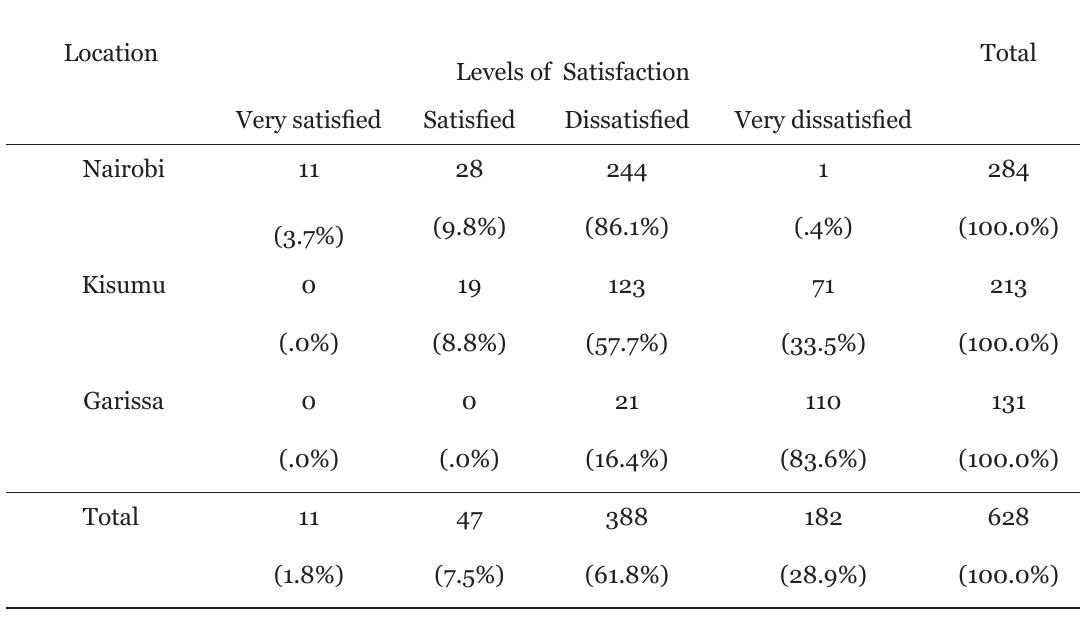
Table 4 Cross-Tabulation of Location of Students and their Levels of Satisfaction